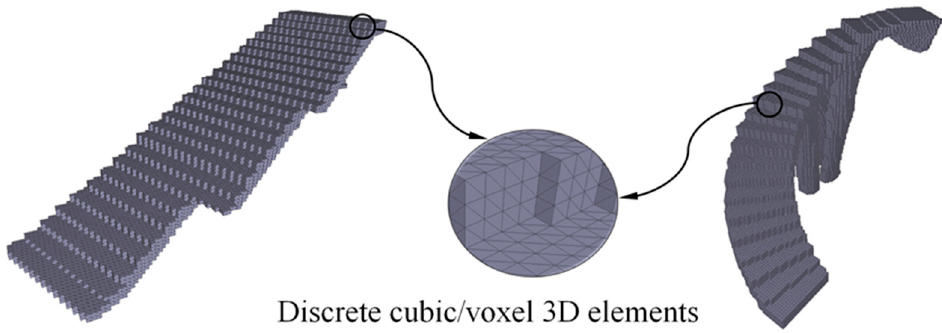
Figure 31. Discretization of the geometry of the constructive elements using cubes or 3D voxels.